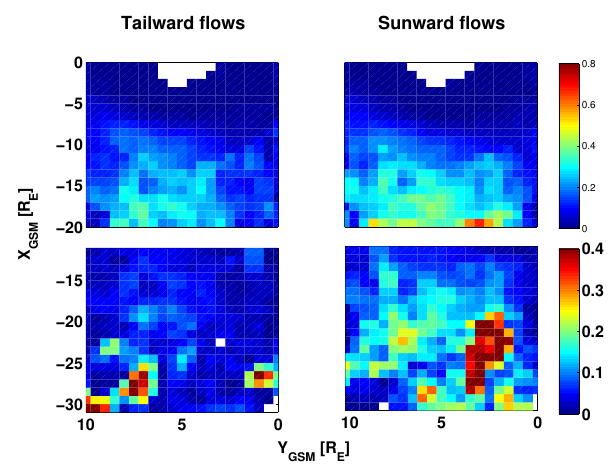
Figure 3. Percentage of observations during which 1min averaged flow speed exceeds 50kms − 1 (upper panels) or 100kms − 1 (lower panels) during studied time interval. The data set is divided into two groups based on the sign of the V X